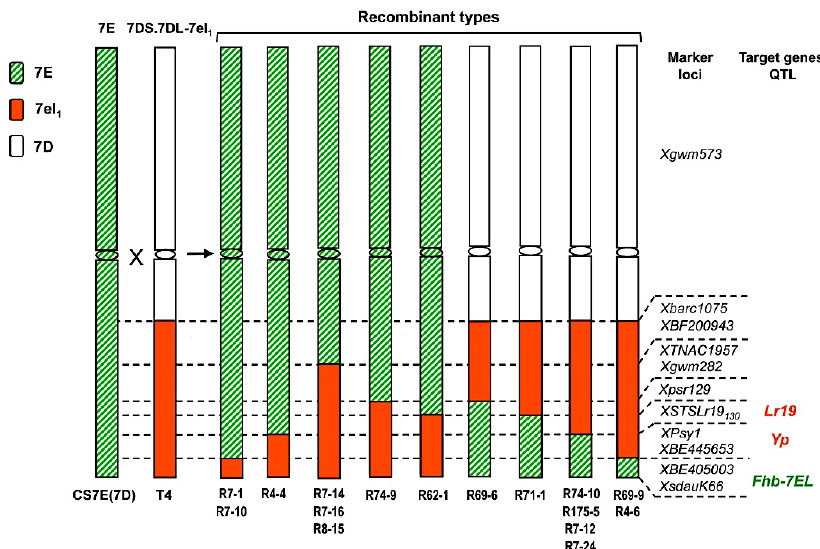
Figure 3. Cytogenetic maps of group-7 chromosomes of parental and recombinant genotypes identified in cross progenies of (CS7E(7D) × T4) F 1 s with normal bread wheat cultivars, based on molecular marker and GISH analyses. 7EL-7el 1 L and 7DL-7el 1 L breakpoints are indicated by dashed lines. Only a subset of tested markers is reported; for additional marker data see [43].